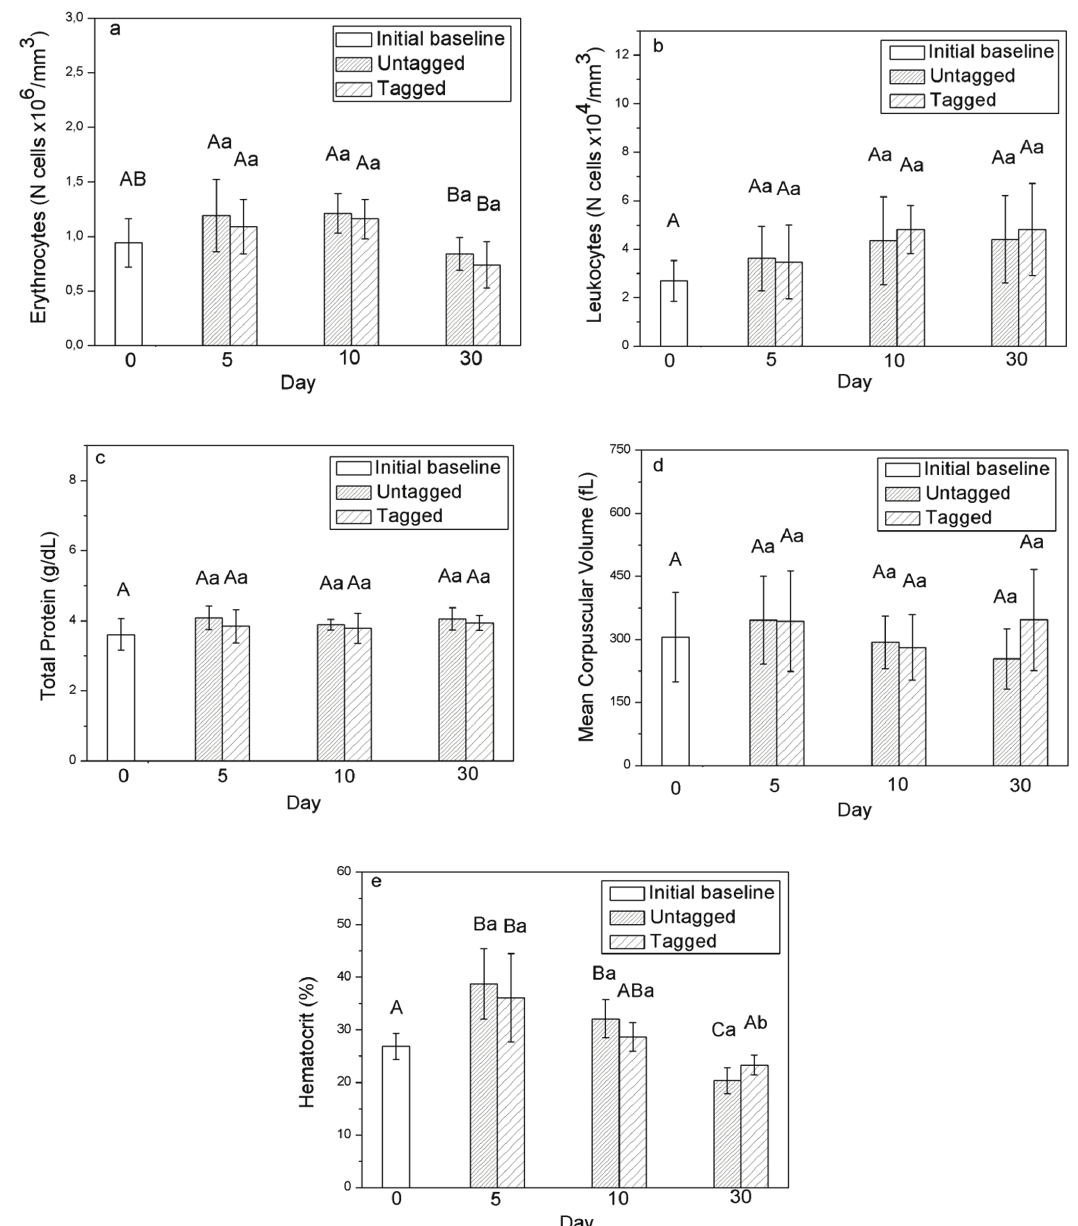
Fig. 4. Hematological parameters of tagged and untagged Lophiosilurus alexandri on the different days analyzed: a. Er. b. Leuk. c. TPP. d. MCV. e. Htc. Means followed by different capital letters differ significantly ( p < 0.05) between days by two- way ANOVA followed by Tukey test. Means with different lowercase letters differ significantly ( p < 0.05) between tagged and untagged fish by Student’s